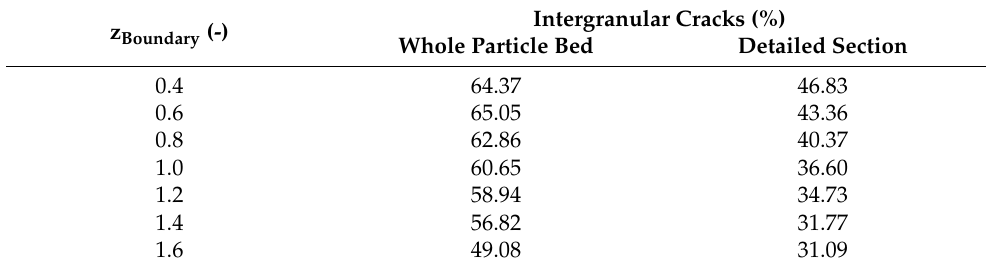
Table 4. Proportions of intergranular cracks of both simulation setups. The intragranular cracks are not listed since they are complementary to the intergranular cracks. Both crack types sum up to 100% for each